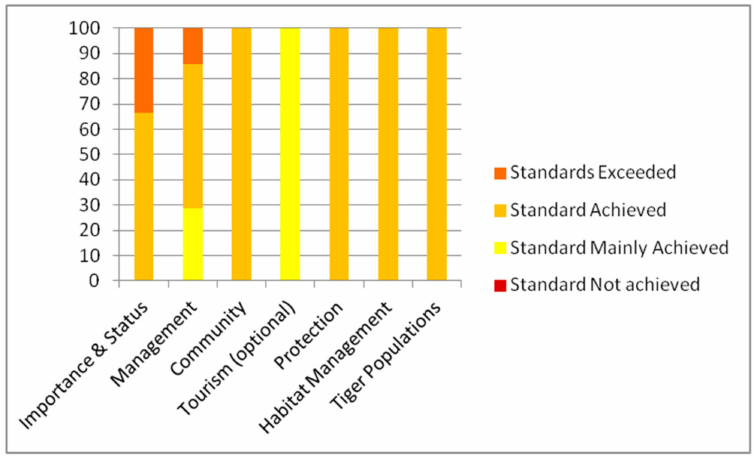
Figure 6. Overview of conformity of the 17 elements under seven pillars of CA|TS (see Figure 2) of CA|TS for Lansdowne Forest